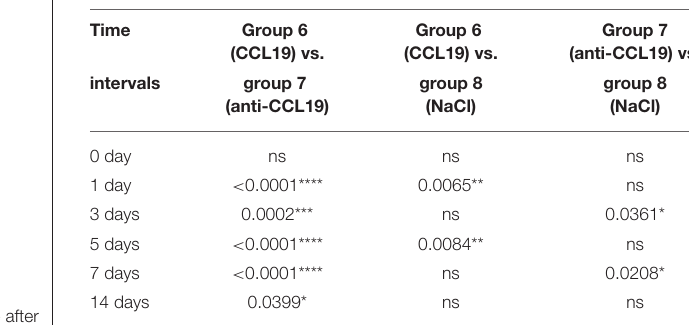
TABLE 2 | p -value of bite force of rats over time after injection of CCL19 and anti-CCL19 antibody.